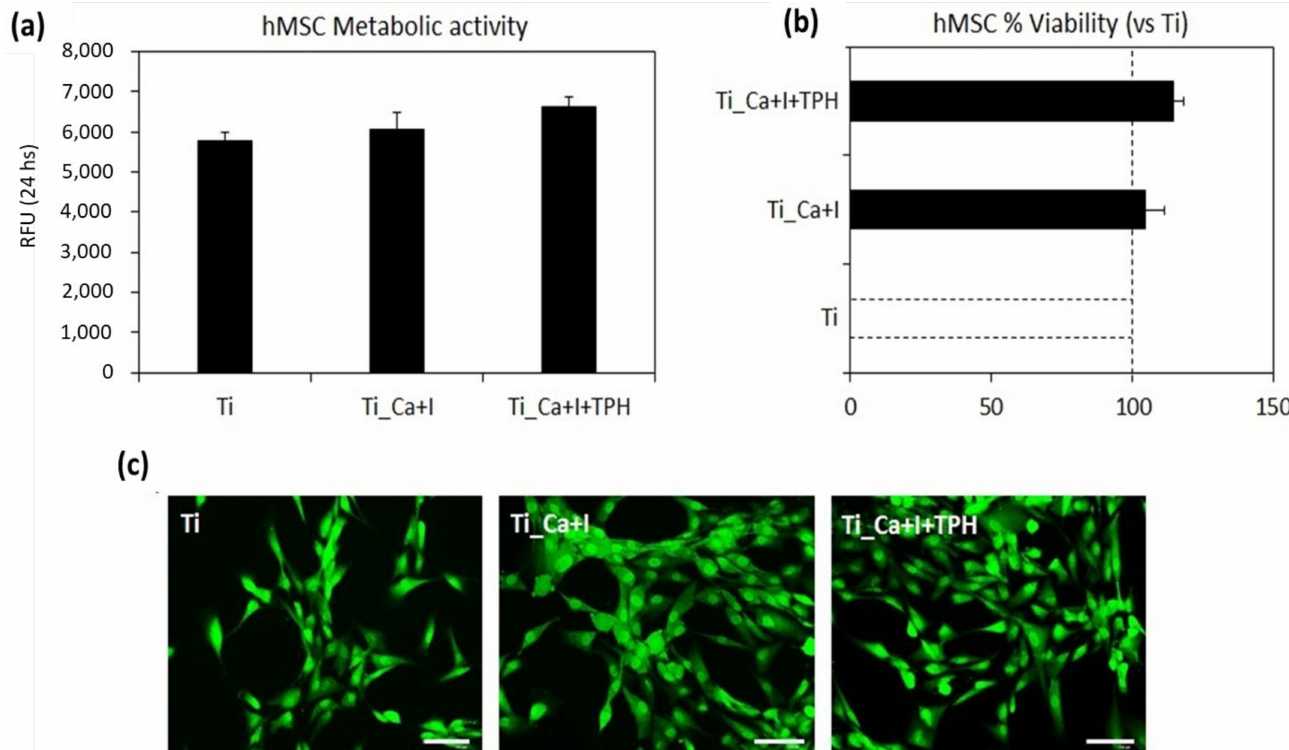
Figure 9. Cytocompatibility evaluation. Surface functionalization with iodine (Ti_Ca+I) and polyphe- nols (Ti_Ca+I+TPH) did not decrease hMSC metabolic activity in comparison to the Ti controls (( a ), p > 0.05) giving a positive boost of ≈ 5% and ≈ 15%, respectively. ( c ), Live/dead images con- firmed that cells were viable (stained in green) with a proper morphology and comparable surface density. ( b ), bars represent means ± dev.st, replicates = 3. Images bar scale = 125 µ